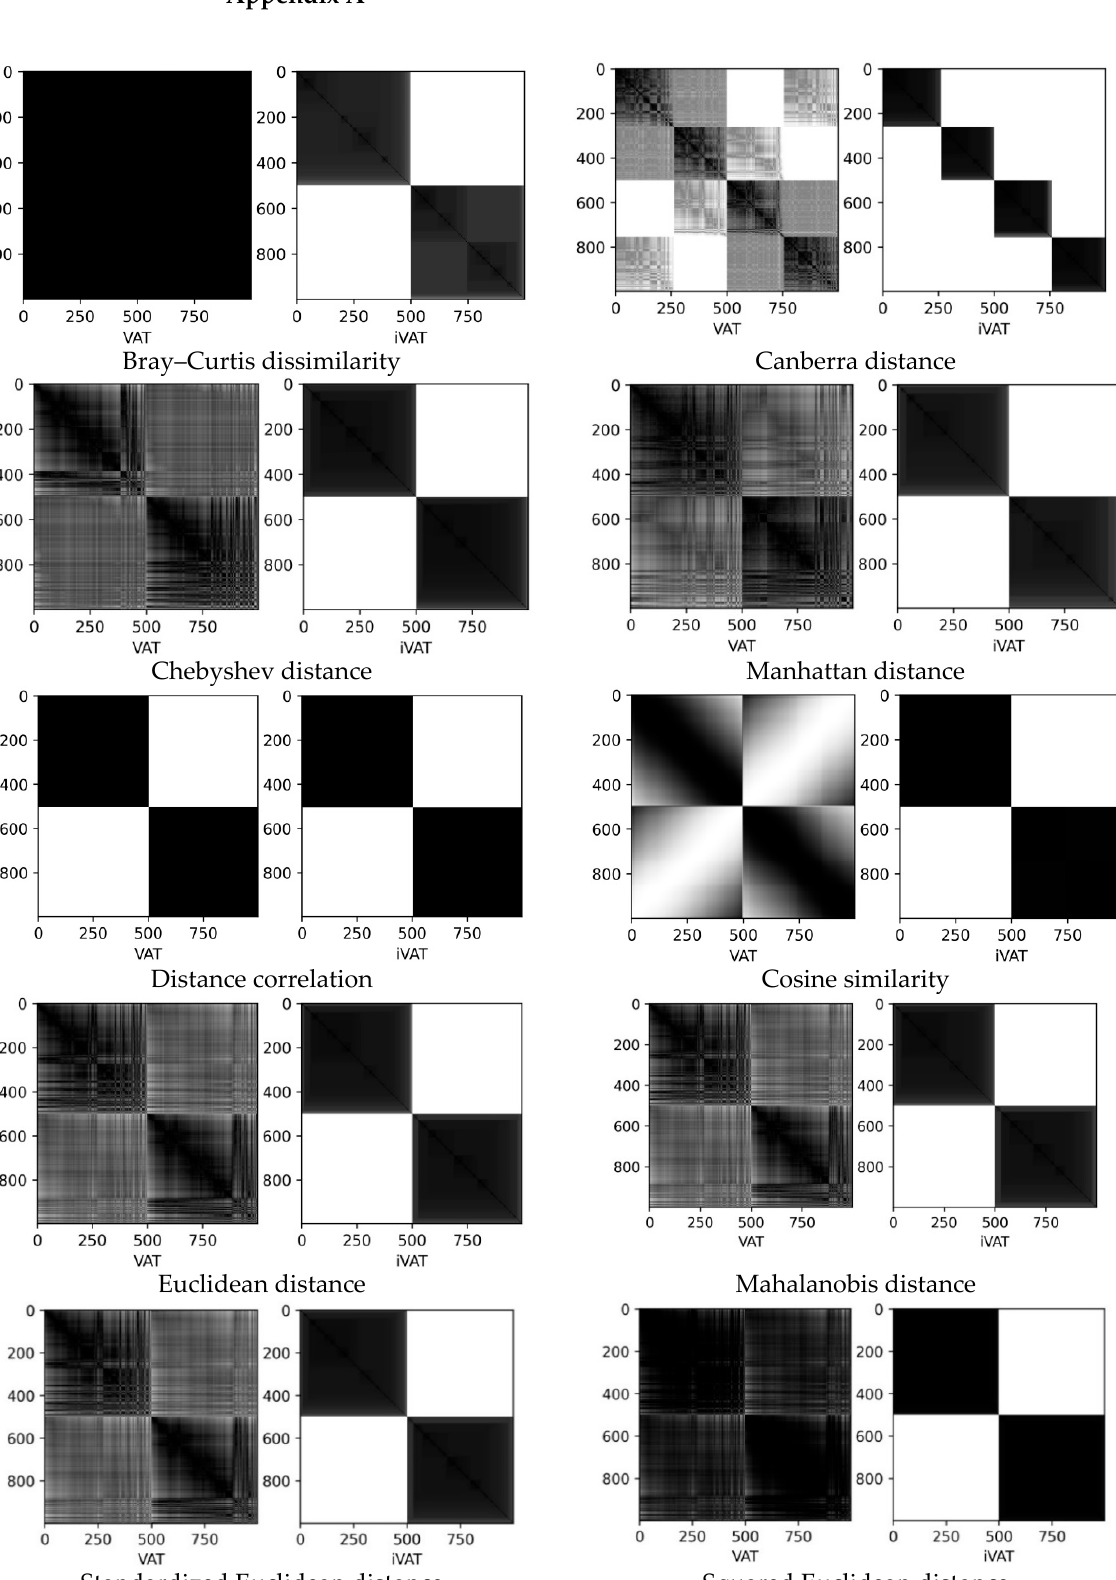
Figure A1. Long2. Cluster heat map.